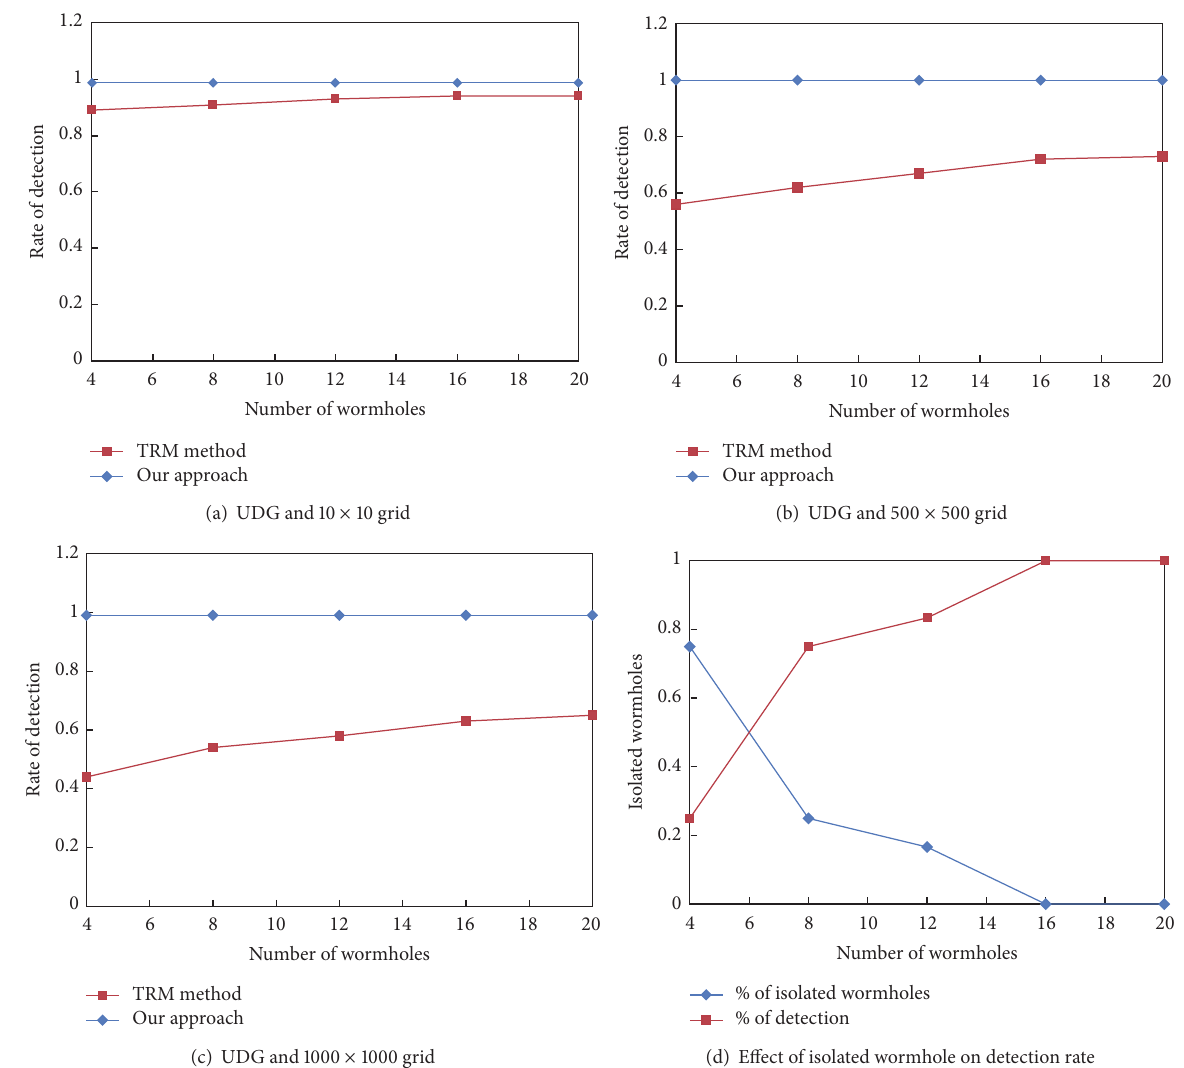
(d) Effect of isolated wormhole on detection rate Figure 3: (a)–(c) show detection efficiency of 20 wormhole nodes in random deployment with varying network field size. (d) Detection efficiency of 20 wormhole nodes in perturbed grid deployment in 1000 × 1000